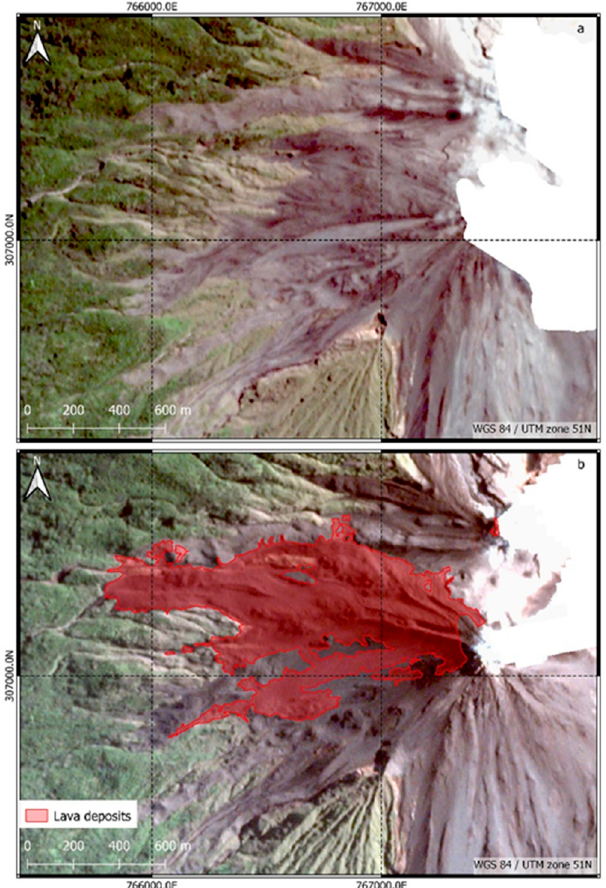
Figure 7. Classification result of lava flows on the W flank of Karangetang (II). ( a ) PlanetScope pre- scene (4 May 2019). ( b ) Classified lava flow area with the post-scene (3 May 2020) in the background. Based on temporal constraints using GVP reports [41,42] and NHI hotspot time series, PlanetScope scenes on 14 March 2018 (pre) and 17 December 2018 (post) were selected for the Krakatau I eruption event. Since hardly any vegetated areas exist on Anak Kraka- tau, no corresponding dNDVI changes could be included in the methodology. Therefore,